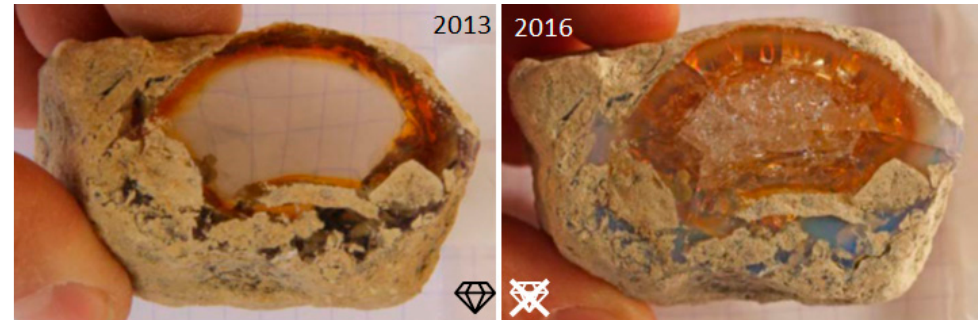
Figure 3. Example of an opal sample collected in 2013 at the mine site (Kok Woha, Wollo Province, Ethiopia, see [39] for details on mines) and the result after 3 years of storage in the atmosphere, where it was allowed to dry.